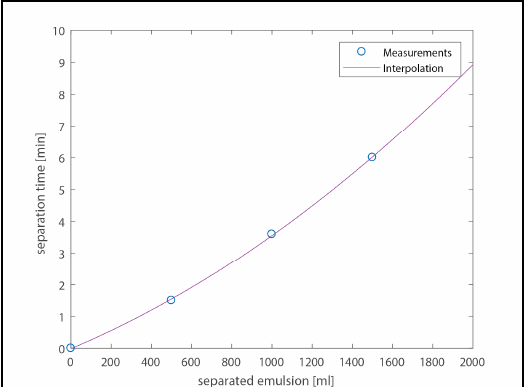
Figure 14. Correlation between the separation time and amount of emulsion separated. An exponential behaviour is observed. Such trend is thought to be due to the impossibility of the water/TBAB layer to escape the filter, therefore covering its surface and increasing the time the oil phase needs to reach the surface.